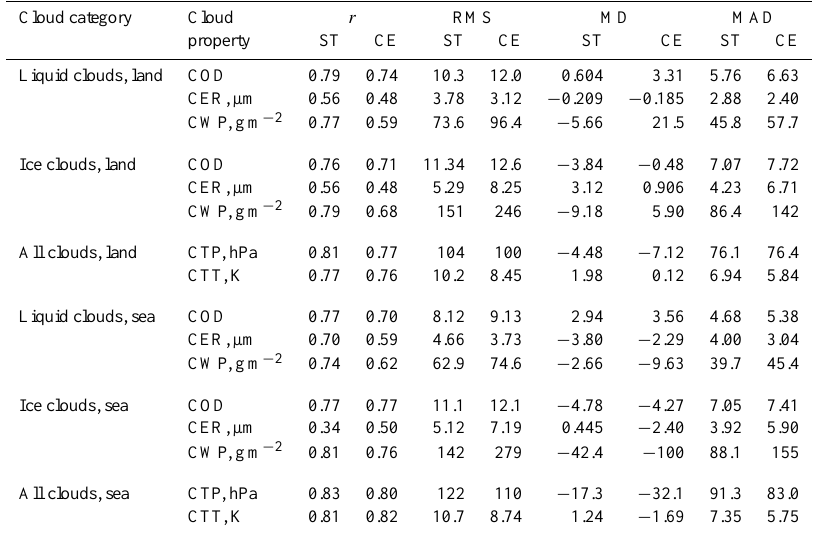
Table 6. Statistics of comparison between daily (1 ◦ averaged) coincident ATSR-2 and MODIS cloud products. Columns labelled ST indicate the MODIS-ST dataset, and columns labelled CE the MODIS-CE dataset. Pearson’s linear correlation coefficient is denoted by r , the root mean square difference RMS, the mean (ATSR-2–MODIS) difference MD, and the mean absolute difference MAD. Cloud